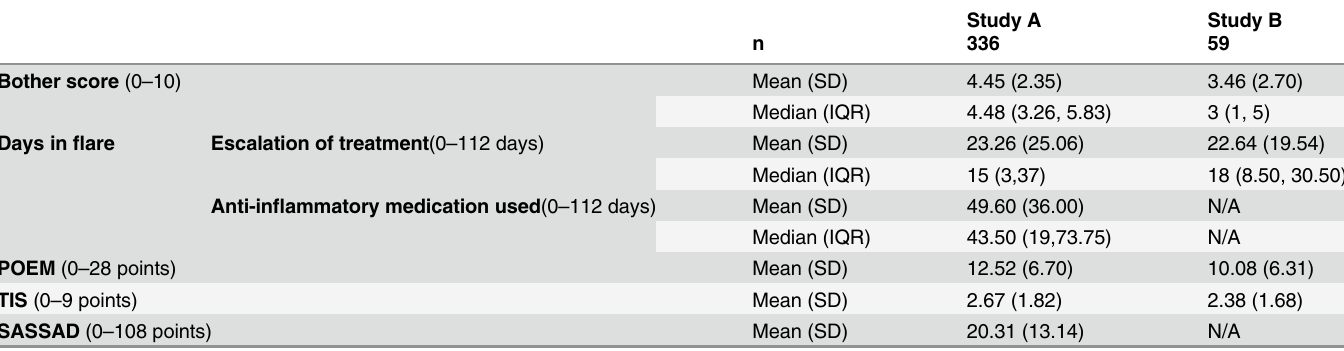
Table 2. Summary of key outcome data over 16 week period of study.